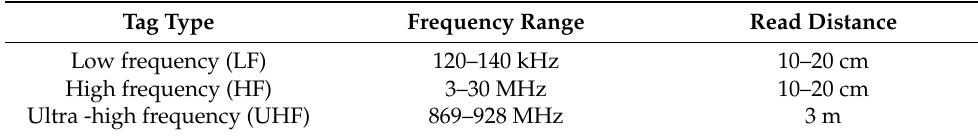
Table 1. Frequency and range comparison. Tag